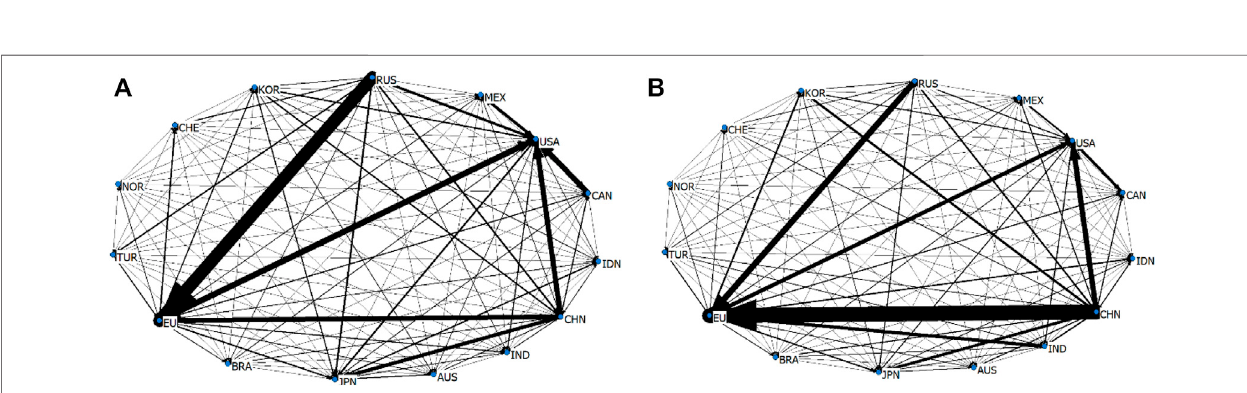
Frontiers in Environmental Science |